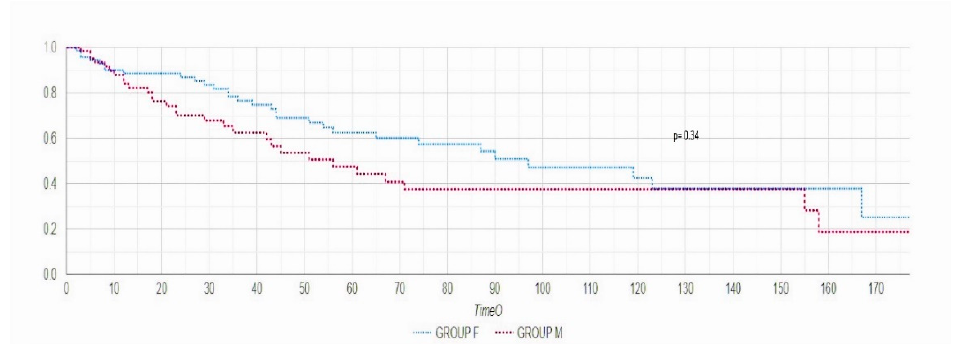
Figure 3. Kaplan–Meier curve during six-month follow-up period did not reveal statistical signifi- cance in terms of combined endpoint of rehospitalization and death.